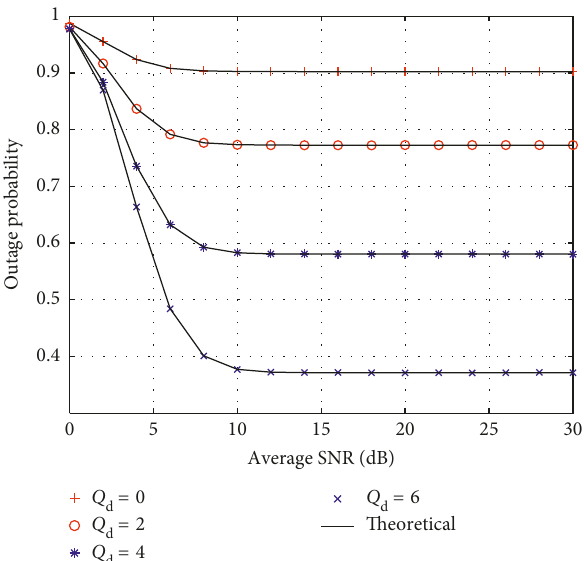
Figure 2: Outage probability for different interference levels.